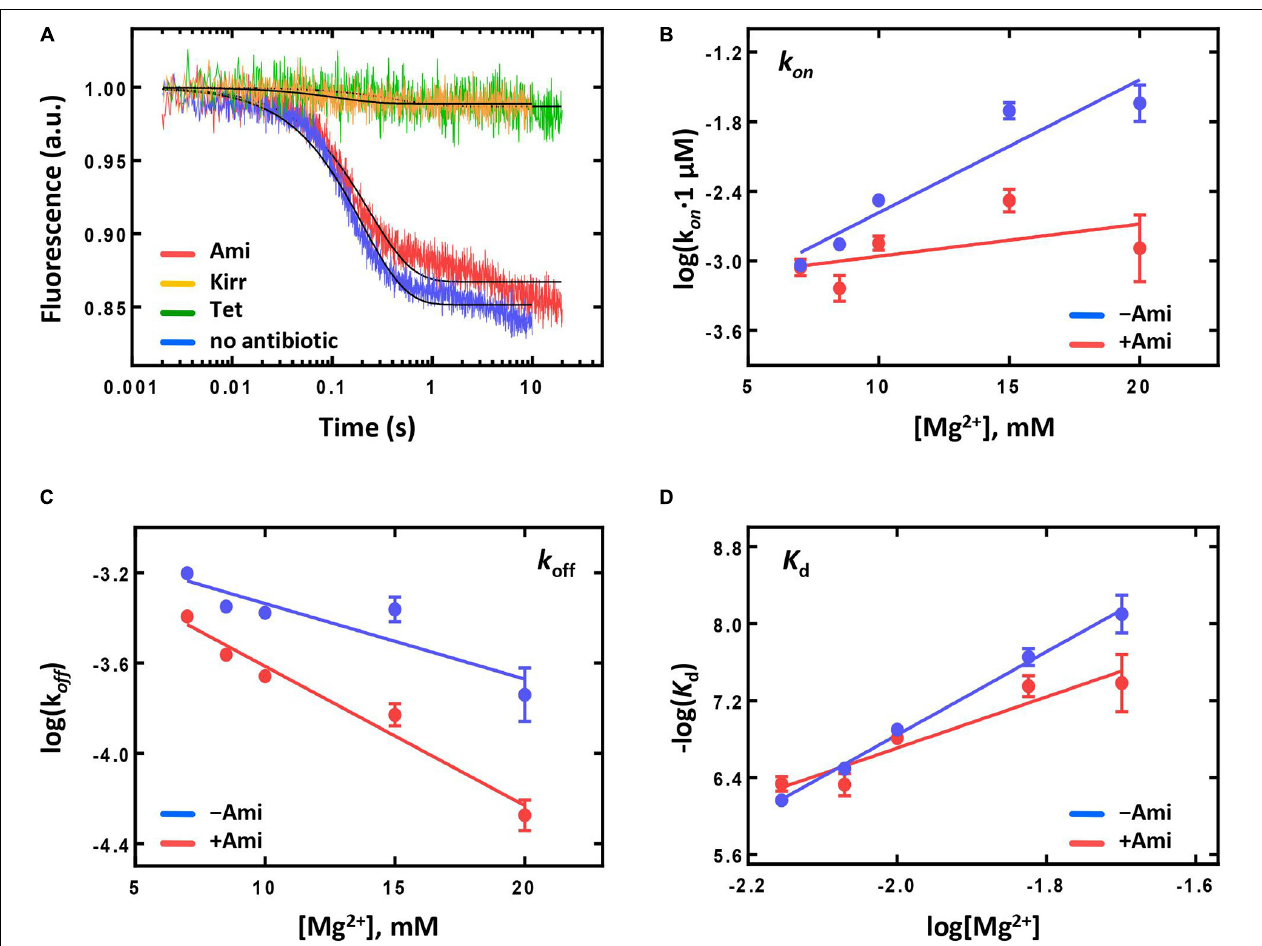
FIGURE 4 | The influence of Ami on the aminoacyl-tRNA binding and the stability of peptidyl-tRNA binding to the A site of the ribosome. (A) The pre-steady-state kinetics of the ternary complex EF-Tu · GTP · Phe-tRNA Phe (2 µ M) interaction with the 70S IC (50 nM) containing fMet-tRNA fMet (Prf20) at the P site without addition of antibiotic (no antibiotic), in the presence of amicoumacin A (Ami), tetracycline (Tet), and kirromycin (Kirr). The dependence of the k on (B) and k off (C) values on the Mg 2 + ion concentration obtained for the pretranslocation complex containing deacylated tRNA fMet at the P site and fMet-[ 14 C]Val-tRNA Val at the A site. (D) The K d values calculated from (B) to (C)